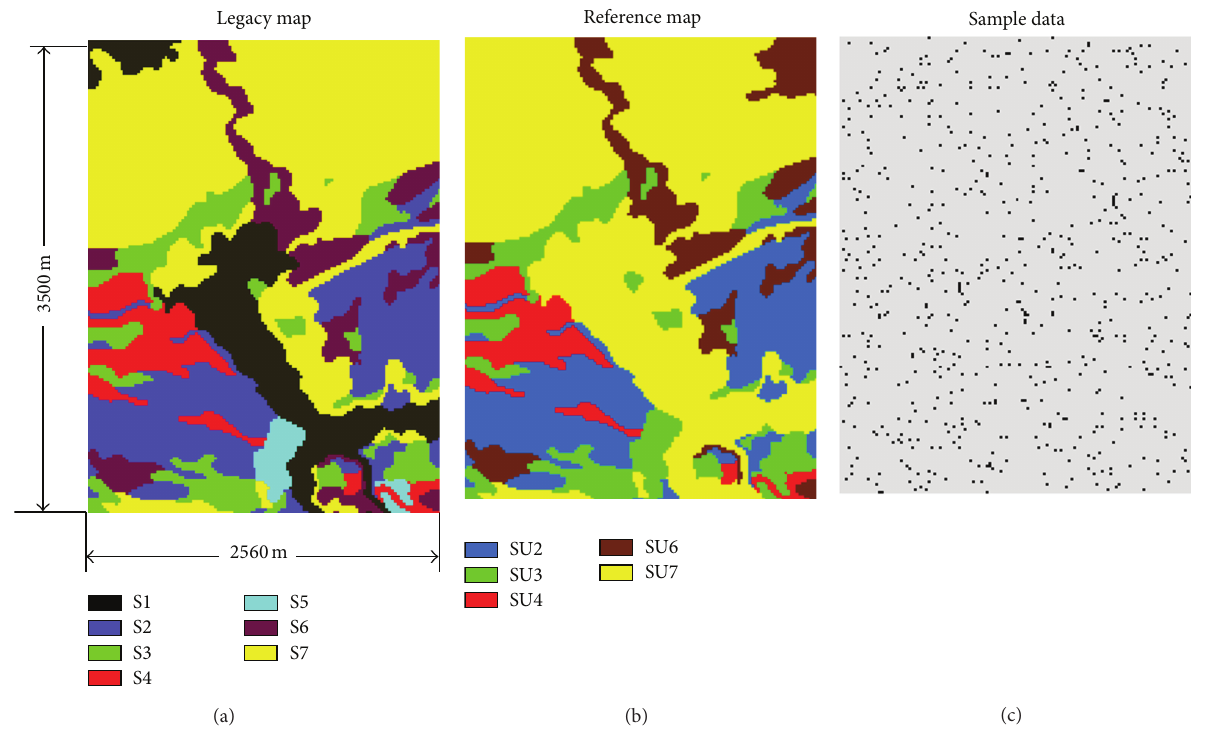
Figure 3: The data for categorical soil map update by Markov chain cosimulation: (a) the legacy soil map; (b) the reference soil map, representing the current distribution of soil series; (c) the sample data set (646 points), including field survey data and pseudosample data directly extracted from the unchanged areas in the legacy soil map. Previous soil series: S1, S2, S3, S4, S5, S6, and S7. Updated soil series: SU2, SU3, SU4, SU6, and SU7. SU2 = S2, SU3 = S3 + S5, SU4 = S4, SU6 = S6 + part of S7, and SU7 = S7 + S1 + part of